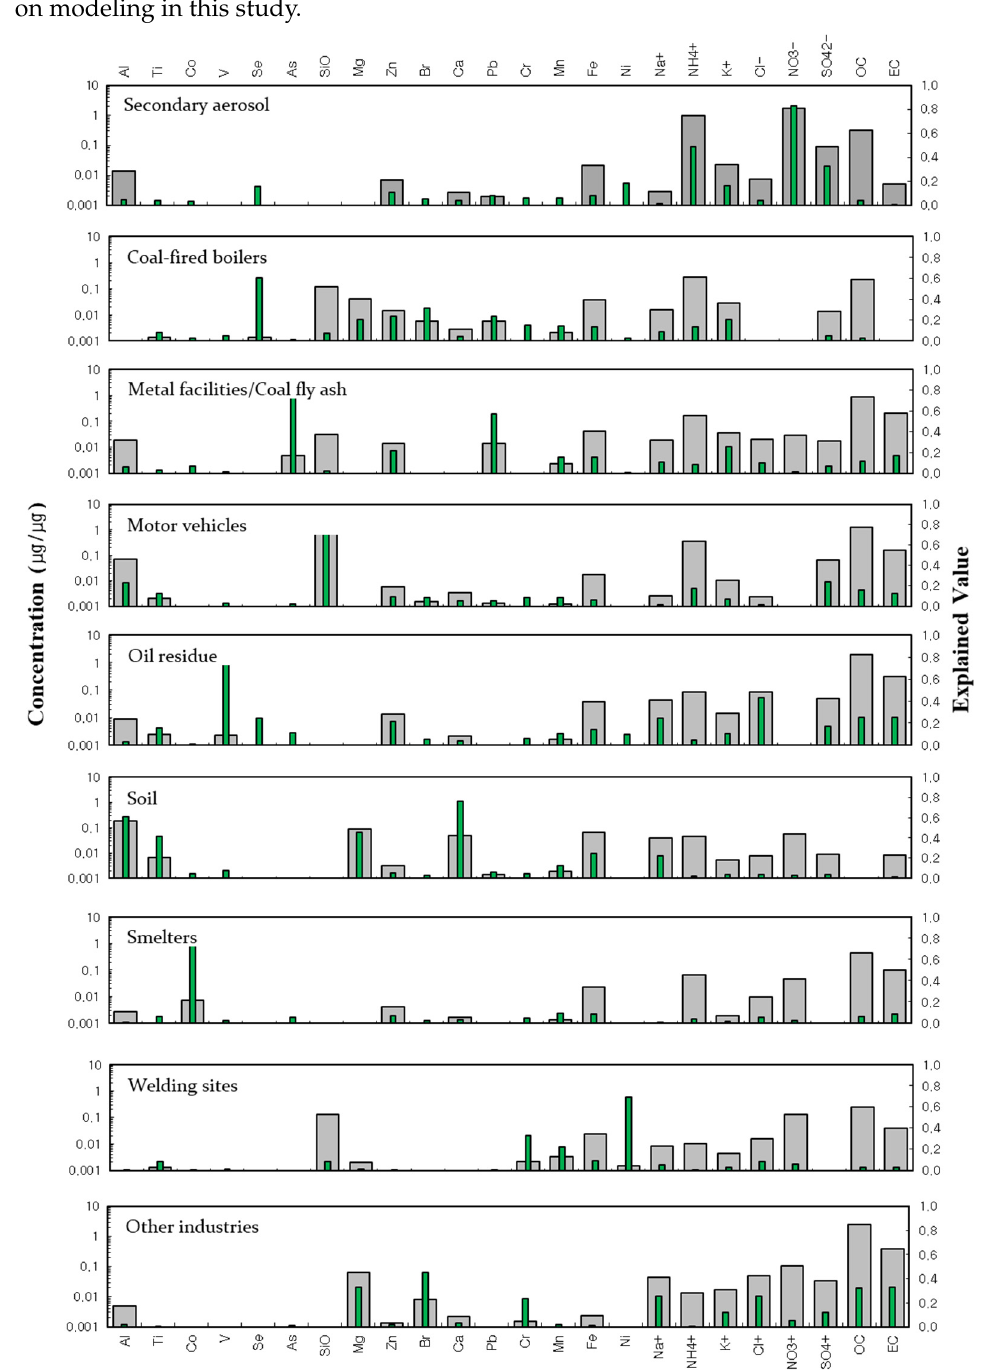
Figure 3. Source profile resolved from PM 2.5 in the study area. Gray: Concentration of species . Green: Percentage of species (%).